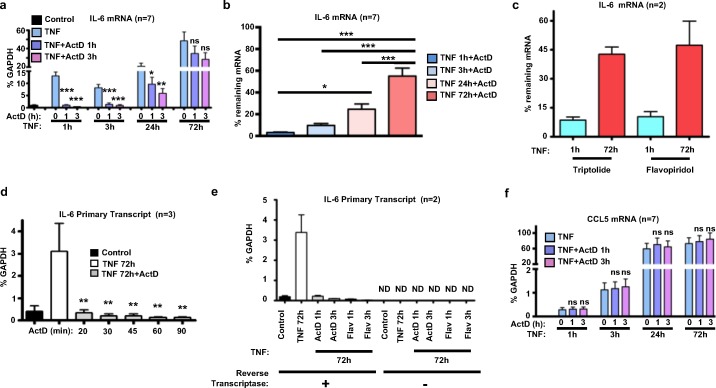
TNF induces late stabilization of IL-6 mRNA in RA FLS.RA FLS were exposed to a single dose of TNF (10 ng/ml) for 1-72h. Subsequently, actinomycin D (Act D; 10 μg/ml) or triptolide (1 μM), or flavopiridol (Flav; 0.5 μM) was added for 1 or 3h and qPCR was used to measure the mRNA levels of IL-6 (a-c), the primary transcripts (PT) of IL6 (d-e), and the mRNA levels of CCL5 (f). For (b-c), the remaining expression of IL-6 after exposure to inhibitors of transcription (Act D, triptolide, and flavopiridol) was calculated as % of the IL-6 mRNA expressed in the absence of inhibitor at the corresponding TNF-stimulated condition. For (a-b) and (f), cumulative results from 7 independent experiments are shown. For (d-e), FLS were exposed to a single dose of TNF (10 ng/ml) for 72 hours and then inhibitors (Act D or flavopiridol) were added for the indicated time points to block active transcription. Primers specific for the fourth intronic region of IL6 were designed to capture primary transcripts of IL6.Values were normalized relative to GAPDH mRNA and presented as mean ±SEM. GAPDH was considered an appropriate internal control for normalizing qPCR results since TNF stimulation had no impact on expression levels and stability status of GAPDH mRNA (S1 Table). P values were calculated by one-way ANOVA and Tukey post-test analysis (* = p<0.05, ** = p<0.01, *** = p<0.001, ns = not significant, and ND = not detected).